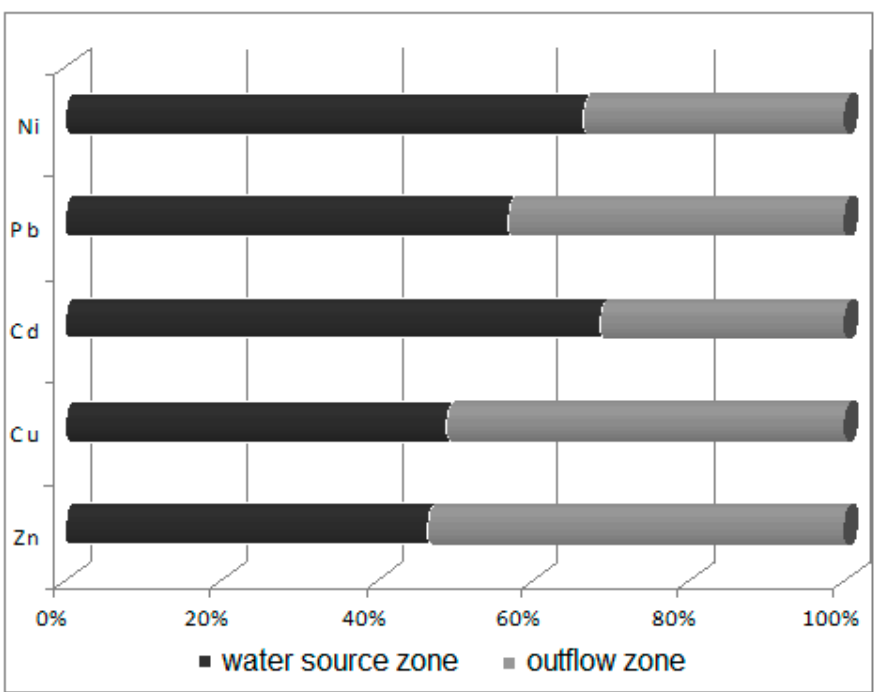
Figure 5. Ratio of sediment heavy metals concentrations in the water source zone to those in the outflow zone.